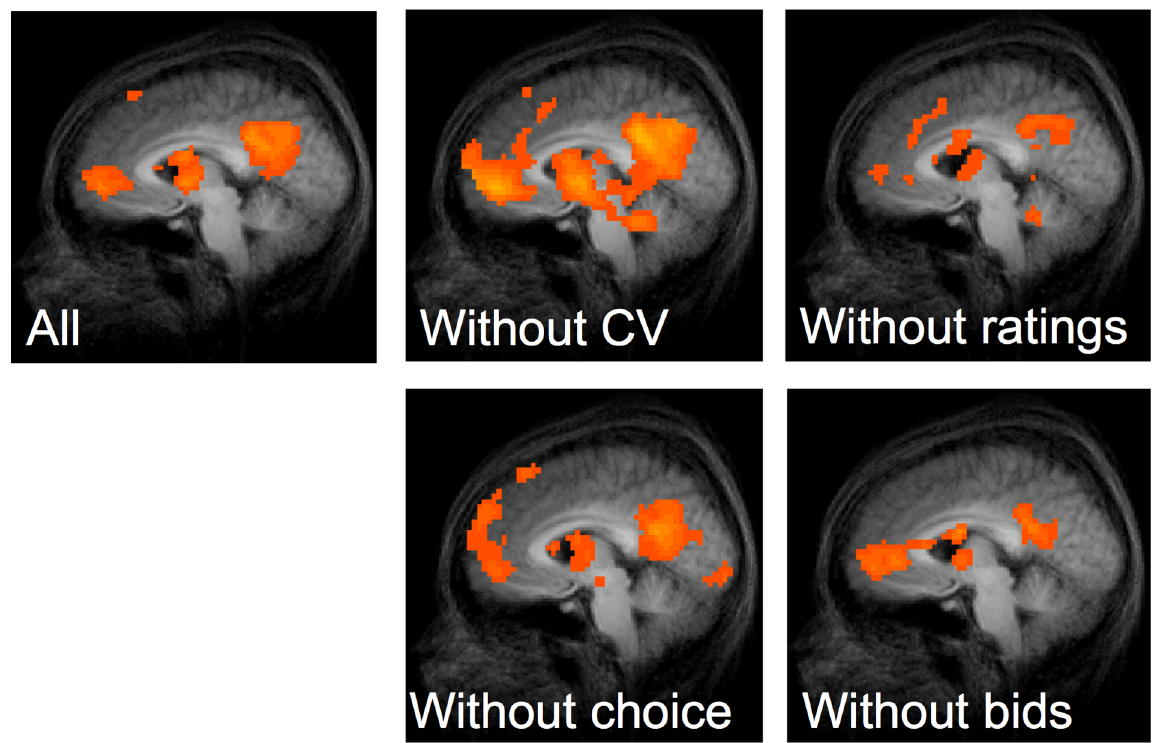
Fig 5. Statistical parameter maps for parametric regression including all behaviorally measured preferences as regressors and all possible “ leave-one-out ” combinations, replicating neural correlates identified in previous studies and meta-studies of subjective valuations. Clockwise from top left: Inclusive of all preferences, leaving out contingent valuations, leaving out activity ratings, leaving out snack food bids, and leaving out consumer good choices. Threshold for each map was set to p < 0.01, FDR